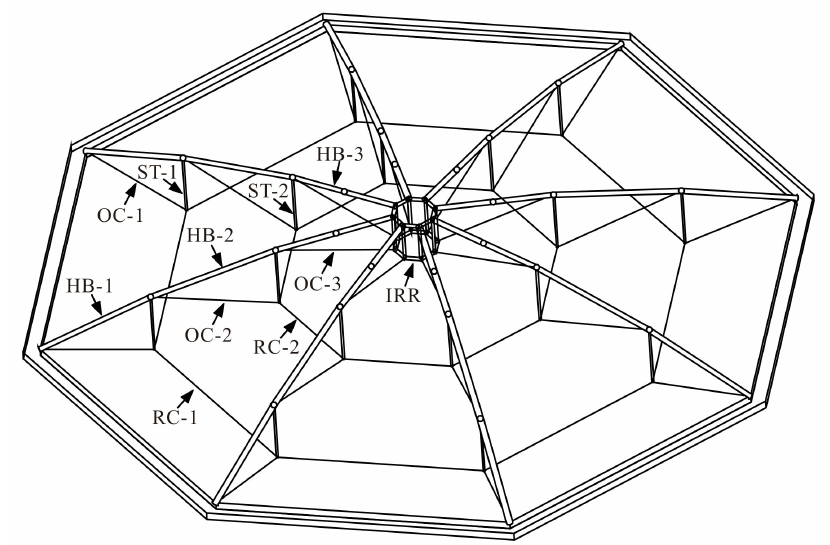
Figure 30. Geiger-Type Ridge-Beam cable dome